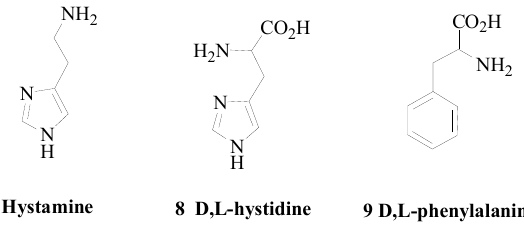
Figure 3. Classical carbonic anhydrase activator (CAAs).